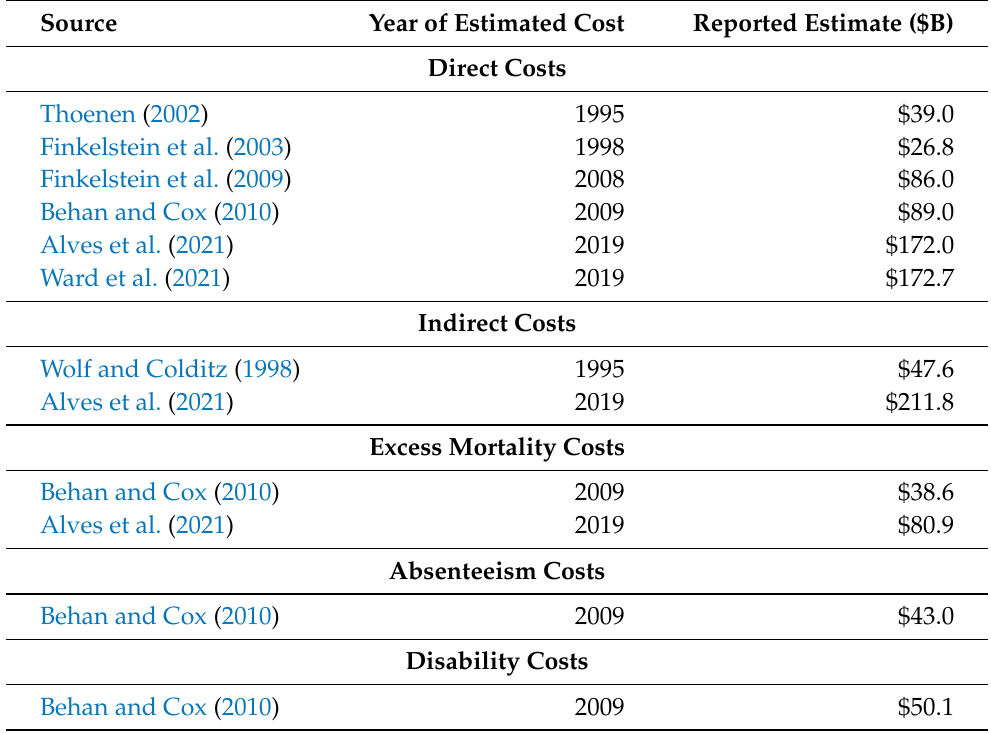
Table 3. Summary of the nominal cost estimates previously reported in the